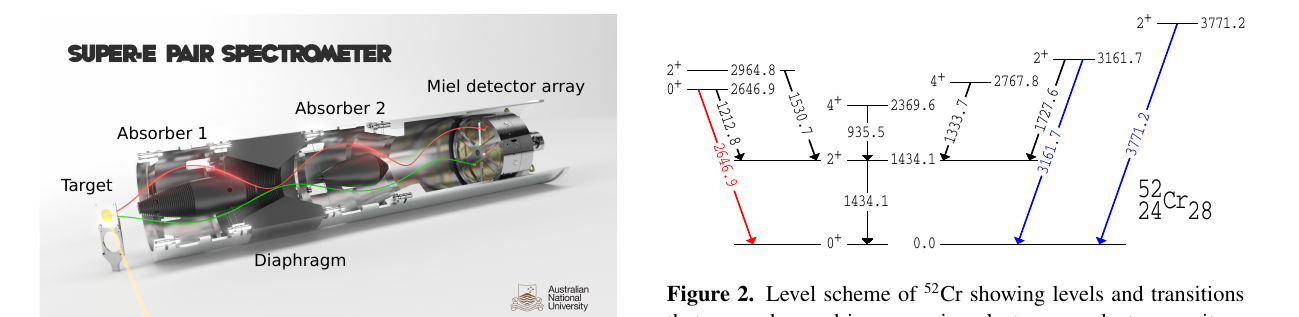
Figure 2. Level scheme of 52 Cr showing levels and transitions that were observed in conversion electrons or electron positron pairs. Transitions that were observed in conversion electrons are in black, transitions observed in electron-positron pairs are shown in blue, and transitions that were observed in both are shown in